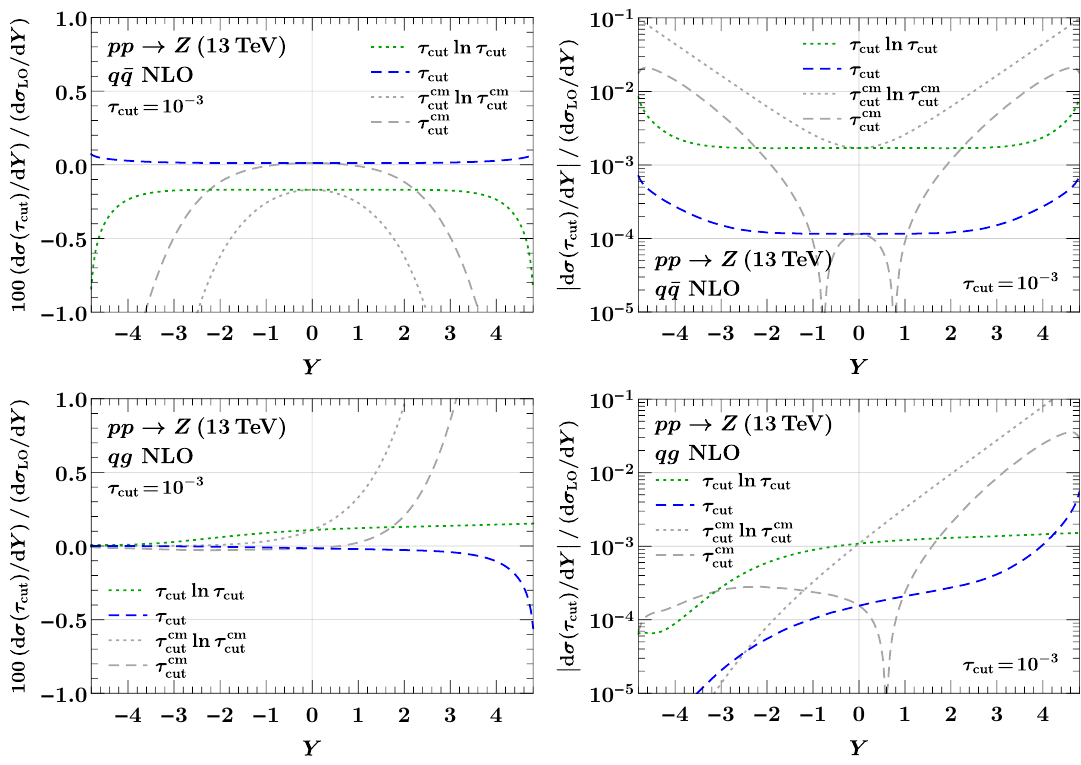
Figure 6 . The NLO NLP corrections as a function of rapidity at (cid:12)xed (cid:28) cut = 10 (cid:0) 3 for Z production for the q (cid:22) q channel (top row) and the qg channel (bottom row). The LL and NLL coe(cid:14)cients for leptonic T are shown by the green dotted and blue dashed curves and for hadronic T by the dotted and dashed gray